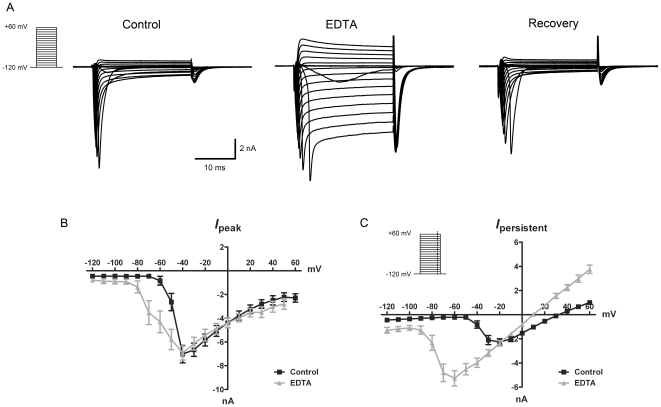
Chelation of external divalent cations activates a voltage-gated current in vagal neurons.Mean ± S.E.M. A, voltage steps of 10 mV increments were applied to vagal neurons held at −120 mV. Neurons were perfused with normal bath solution (Control and Recovery) or bath solution containing 5 mM EDTA with nominally 0 mM Ca2+ and 0 mM Mg2+ (EDTA). The resulting currents are depicted. B, the current-voltage relationship of the peak amplitude of the fast component of the current (n = 8 and 14 for Control (black squares) and EDTA (grey triangles) respectively). C, the current-voltage relationship of the persistent component of the current recorded at 24.5 ms after the onset of the voltage step (indicated by dotted line in inset; n = 24).